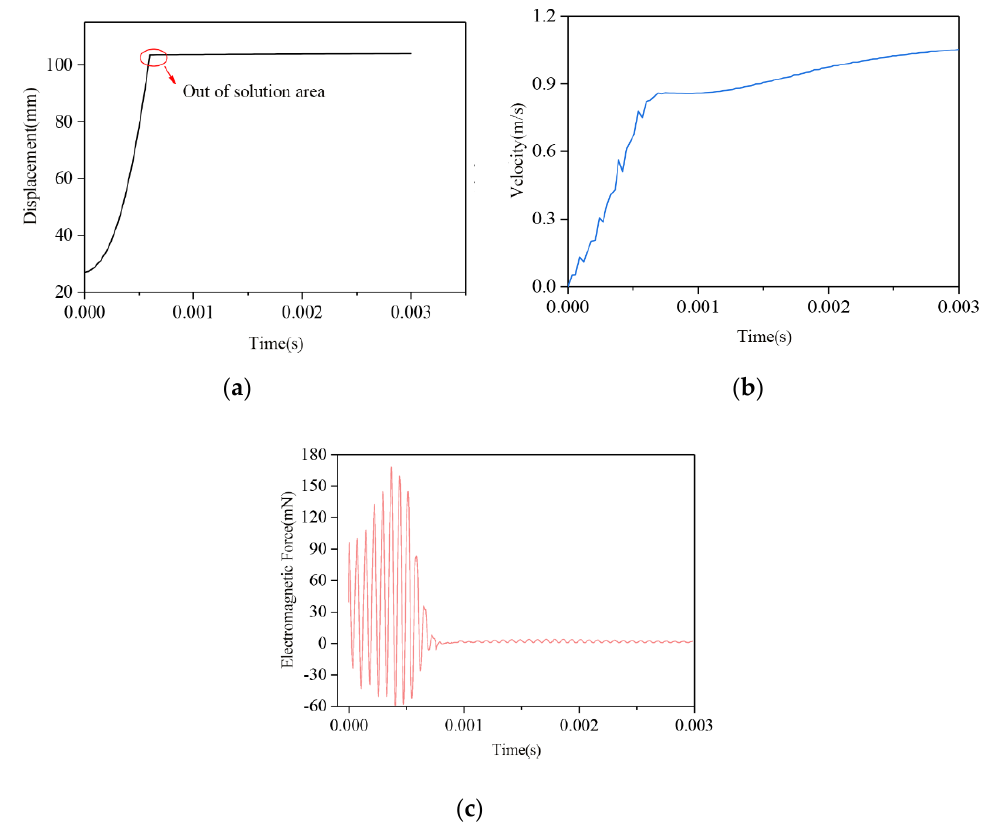
Figure 7. Dynamic parameters of non-ferromagnetic metals in horizontal flight state. ( a ) Horizontal displacement; ( b ) velocity of metal; ( c ) horizontal EMF.